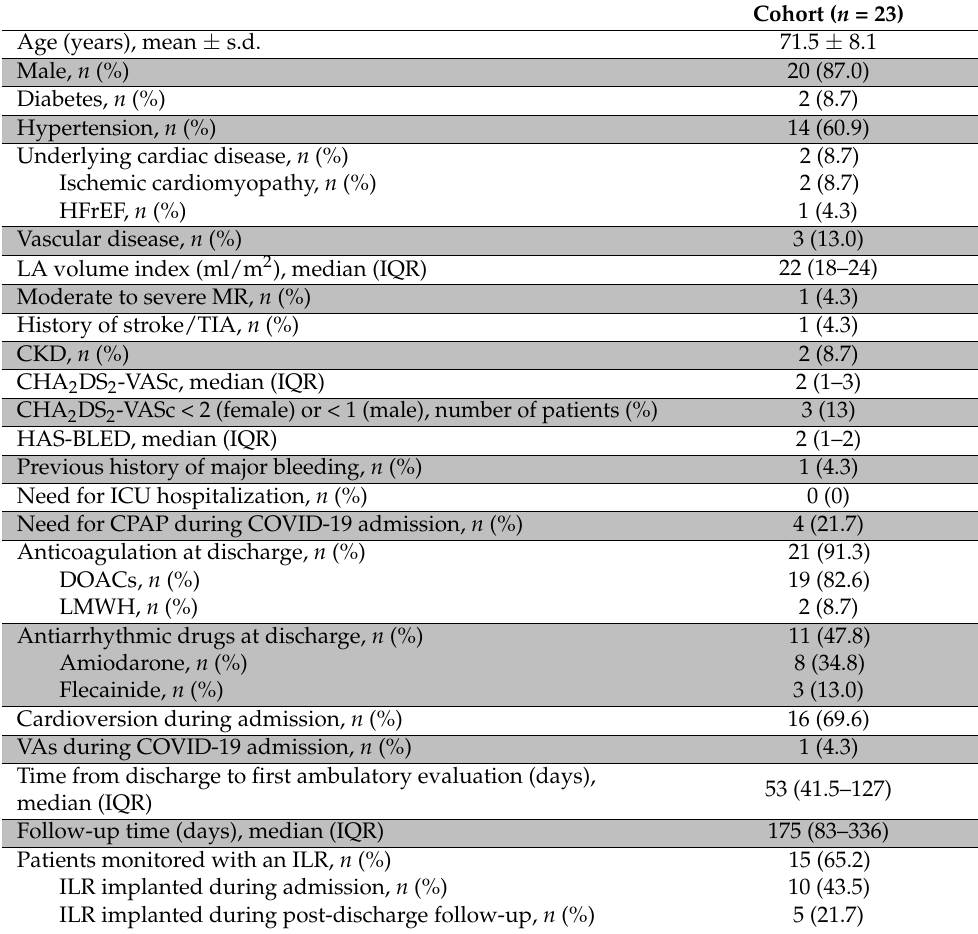
Table 1. Characteristics of the study